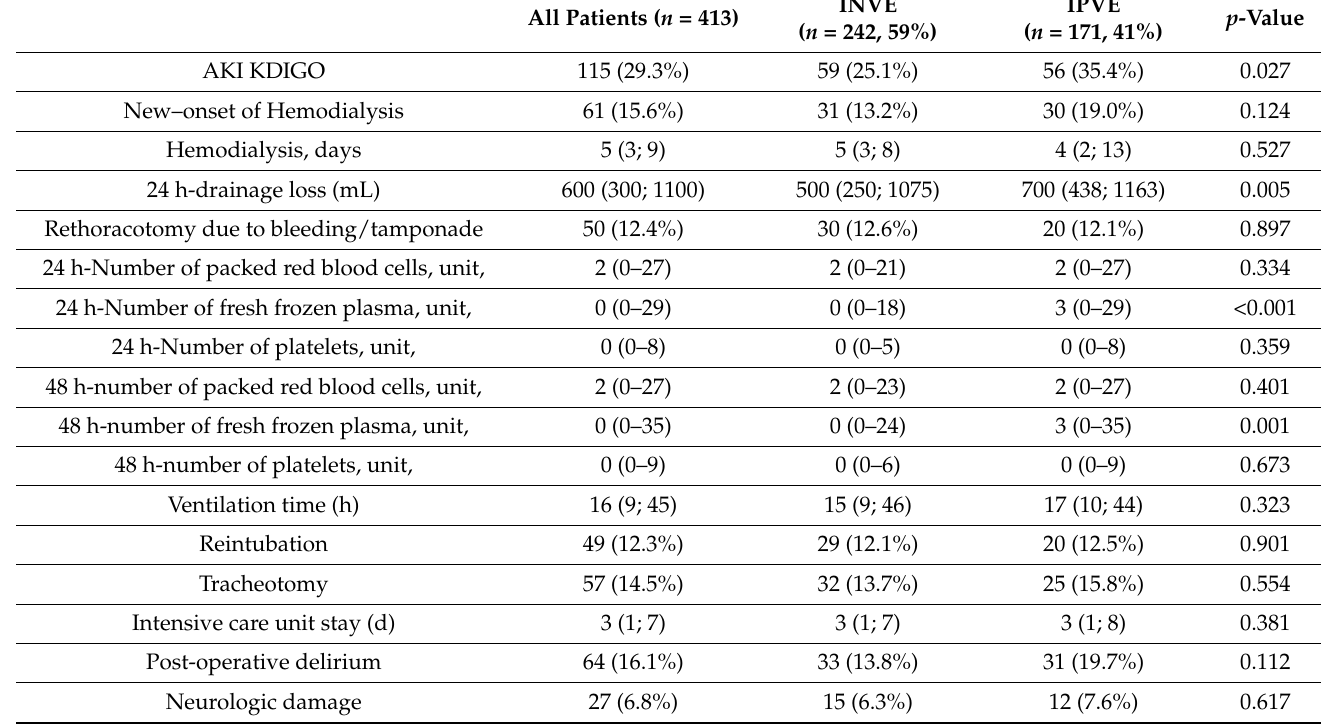
Table 3. Post-operative data and